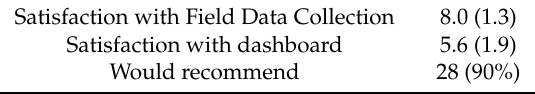
Table 5. Mean level of satisfaction with current MST: score out of 10 (standard deviation).